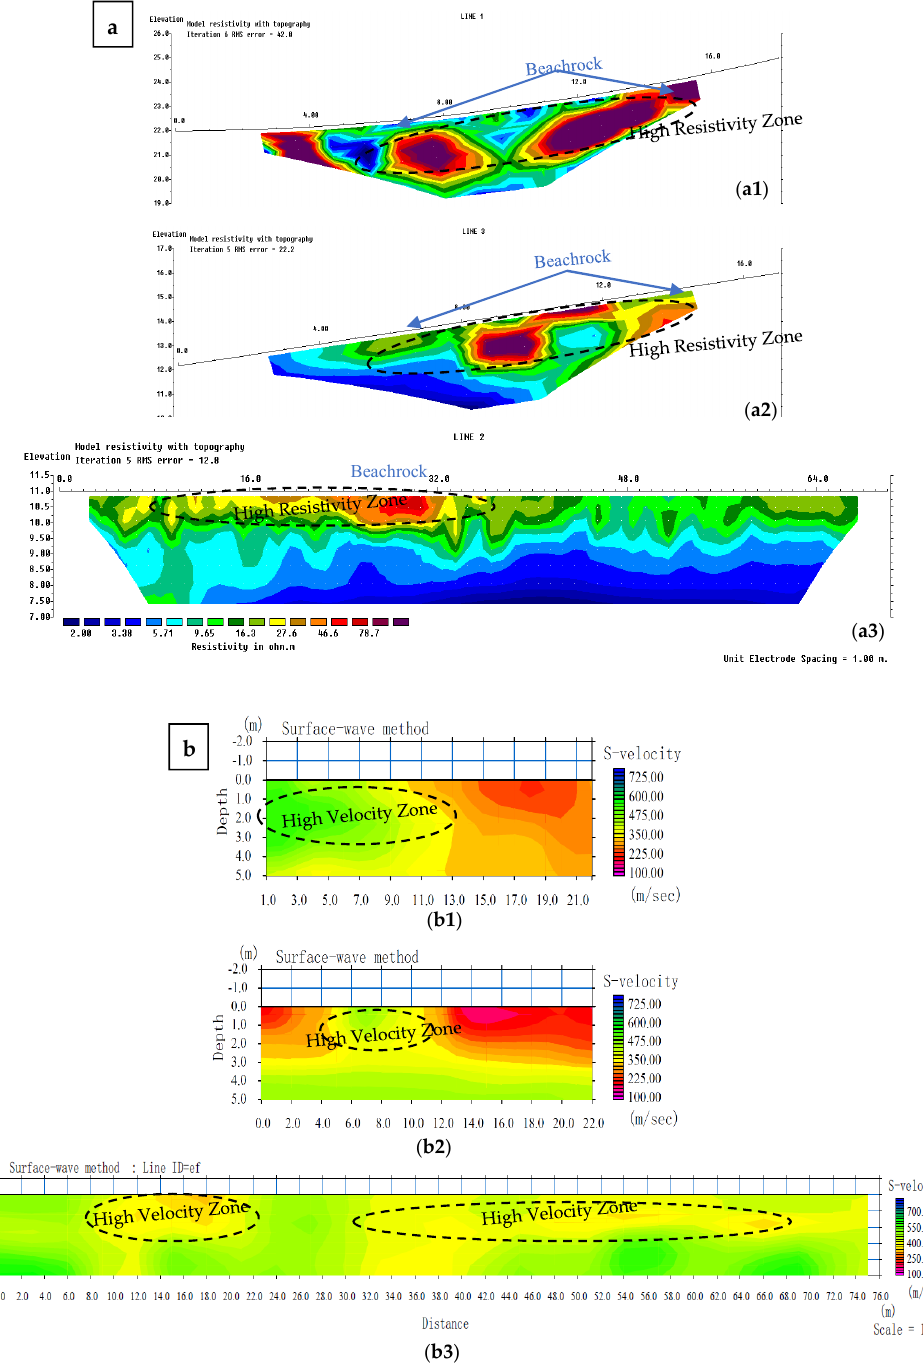
Figure 3. Electrical and multi analysis surface wave results of α-section. ( a1 ) the resistivity of line 1, ( b1 ) the MASW of line 1, ( a2 ) the resistivity of line 3, ( b2 ) the MASW of line 3, ( a3 ) the resistivity of line 2, ( b3 ) the MASW of line 2.